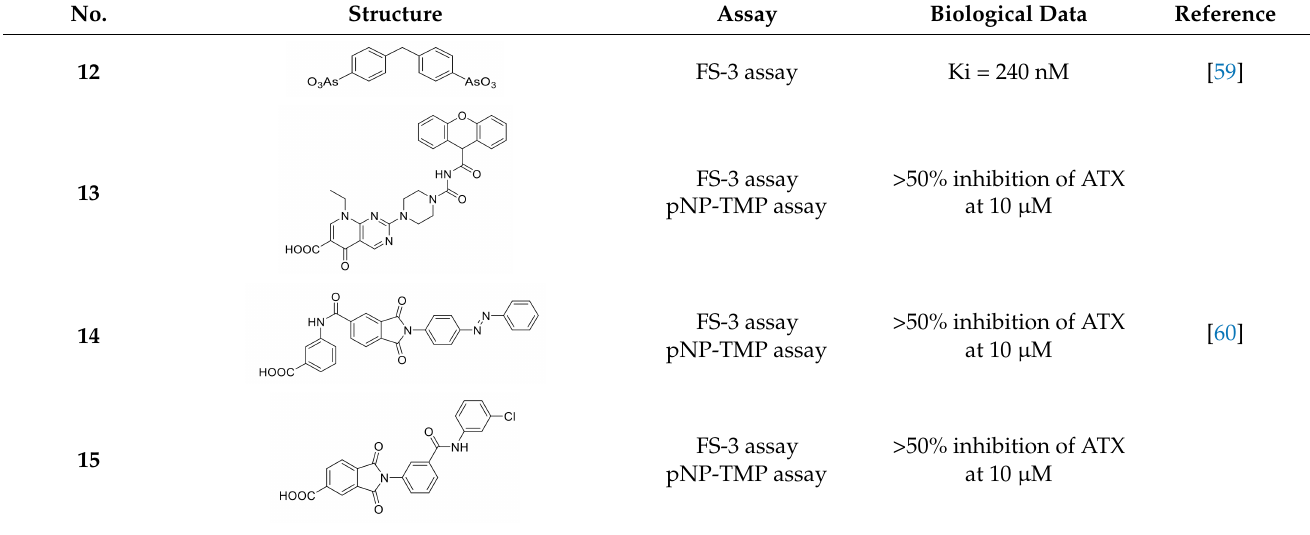
Table 2. Compound 12 – 19